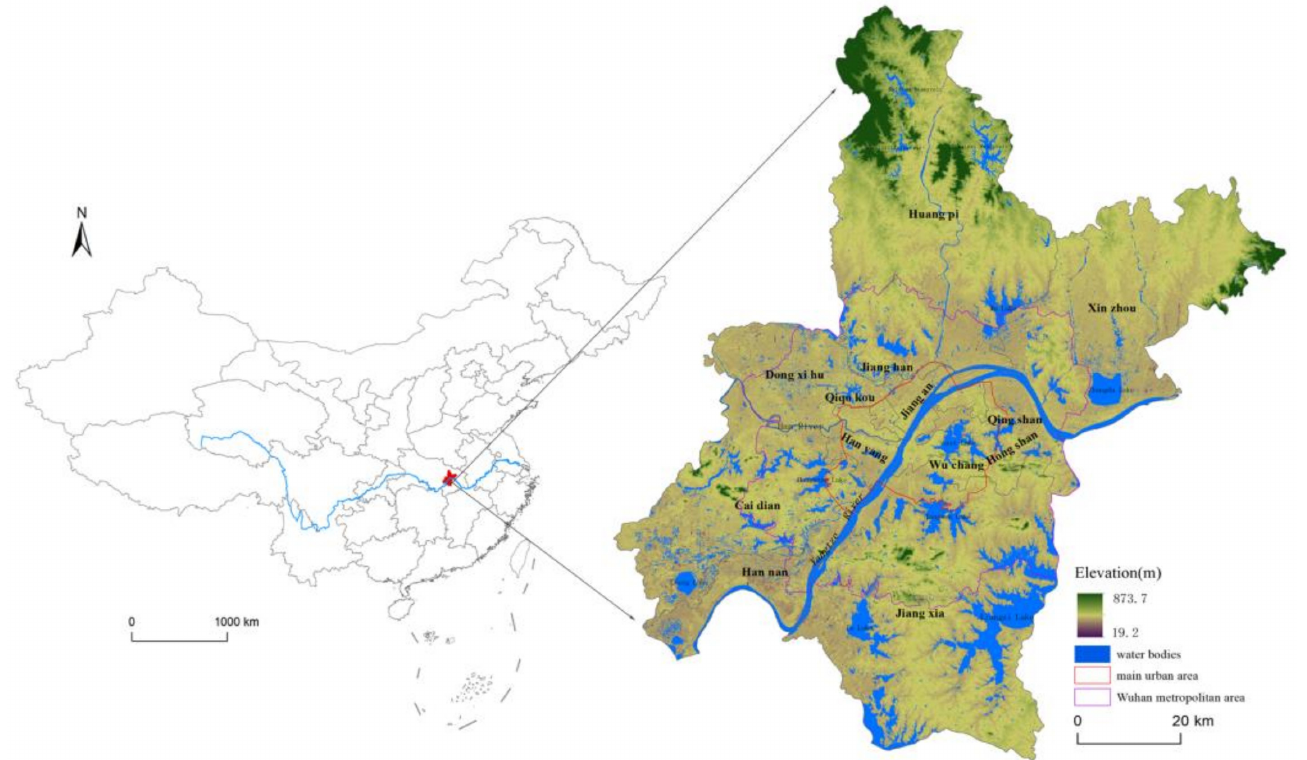
Figure 1. Location of Wuhan in